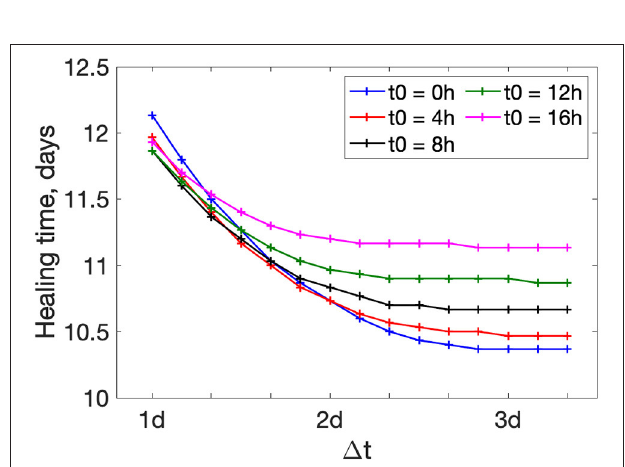
FIGURE 5 | Wound healing time dependence of treatment duration 1 t for different beginning times t 0 . r p = 0.9